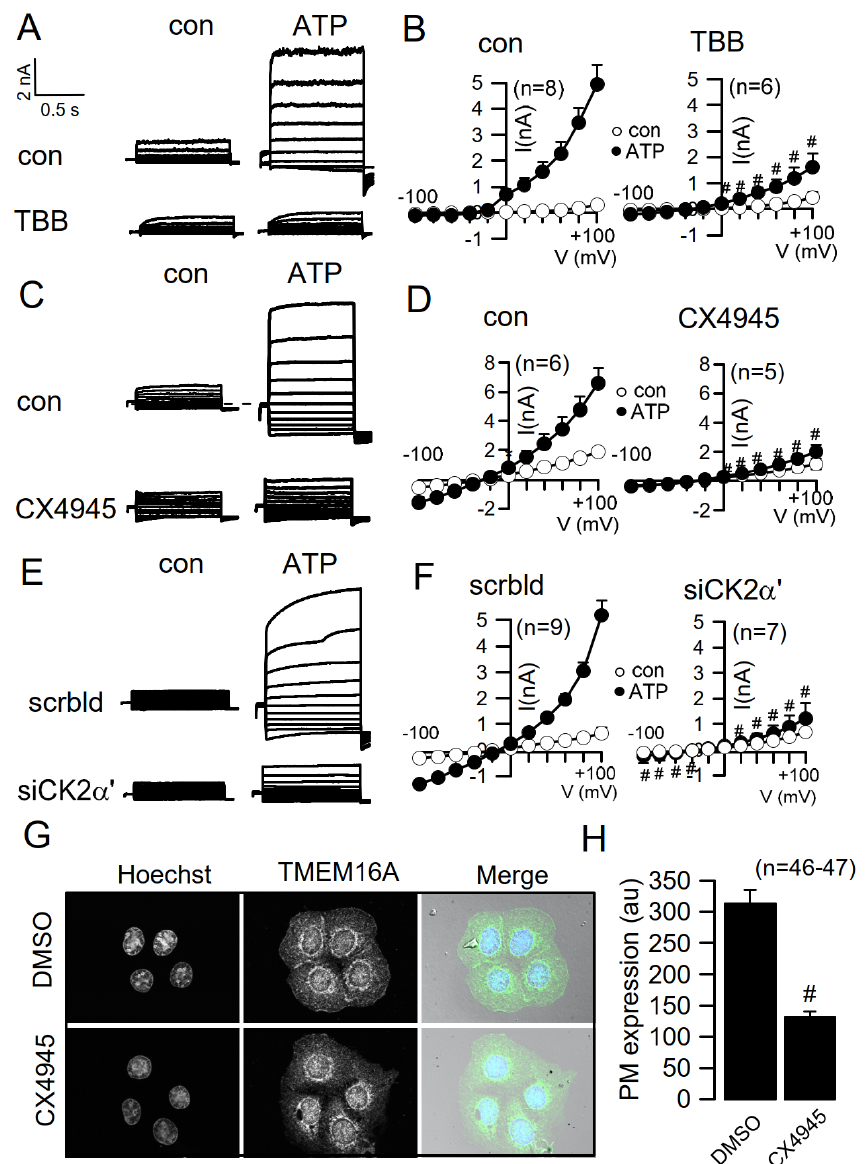
Figure 2. Inhibitors of CK2 inhibit TMEM16A in CFBE airway epithelial cells. ( A – F ) Whole cell